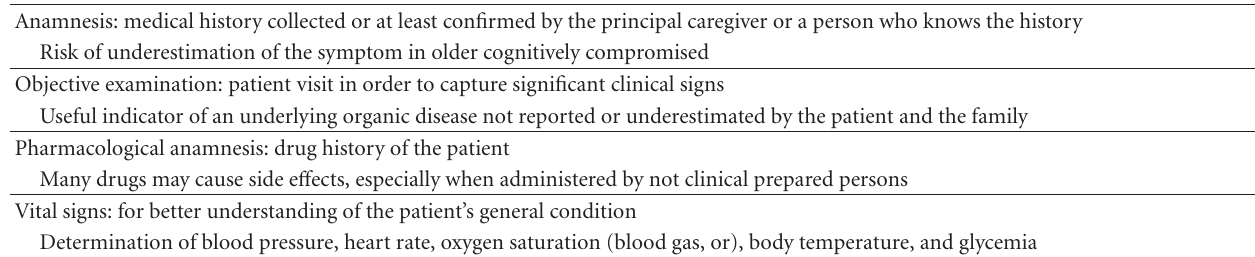
Table 3: Clinical assessment of patients with